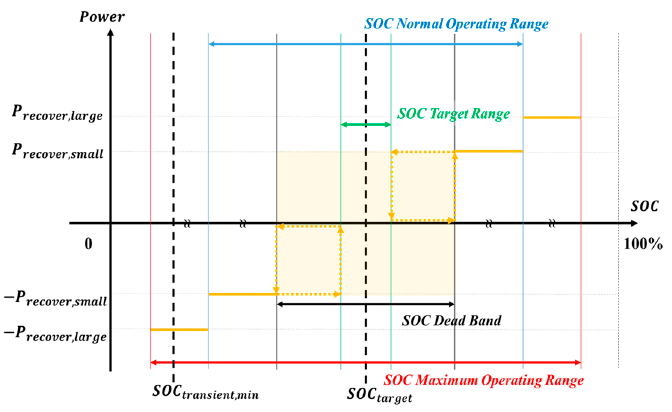
Figure 6. Recovery control of BESS on state of charge (SOC) ranges.